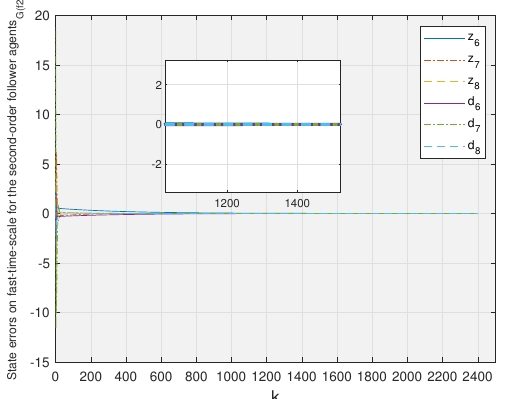
Figure 6. State errors on fast-time scale for the second-order follower agents.